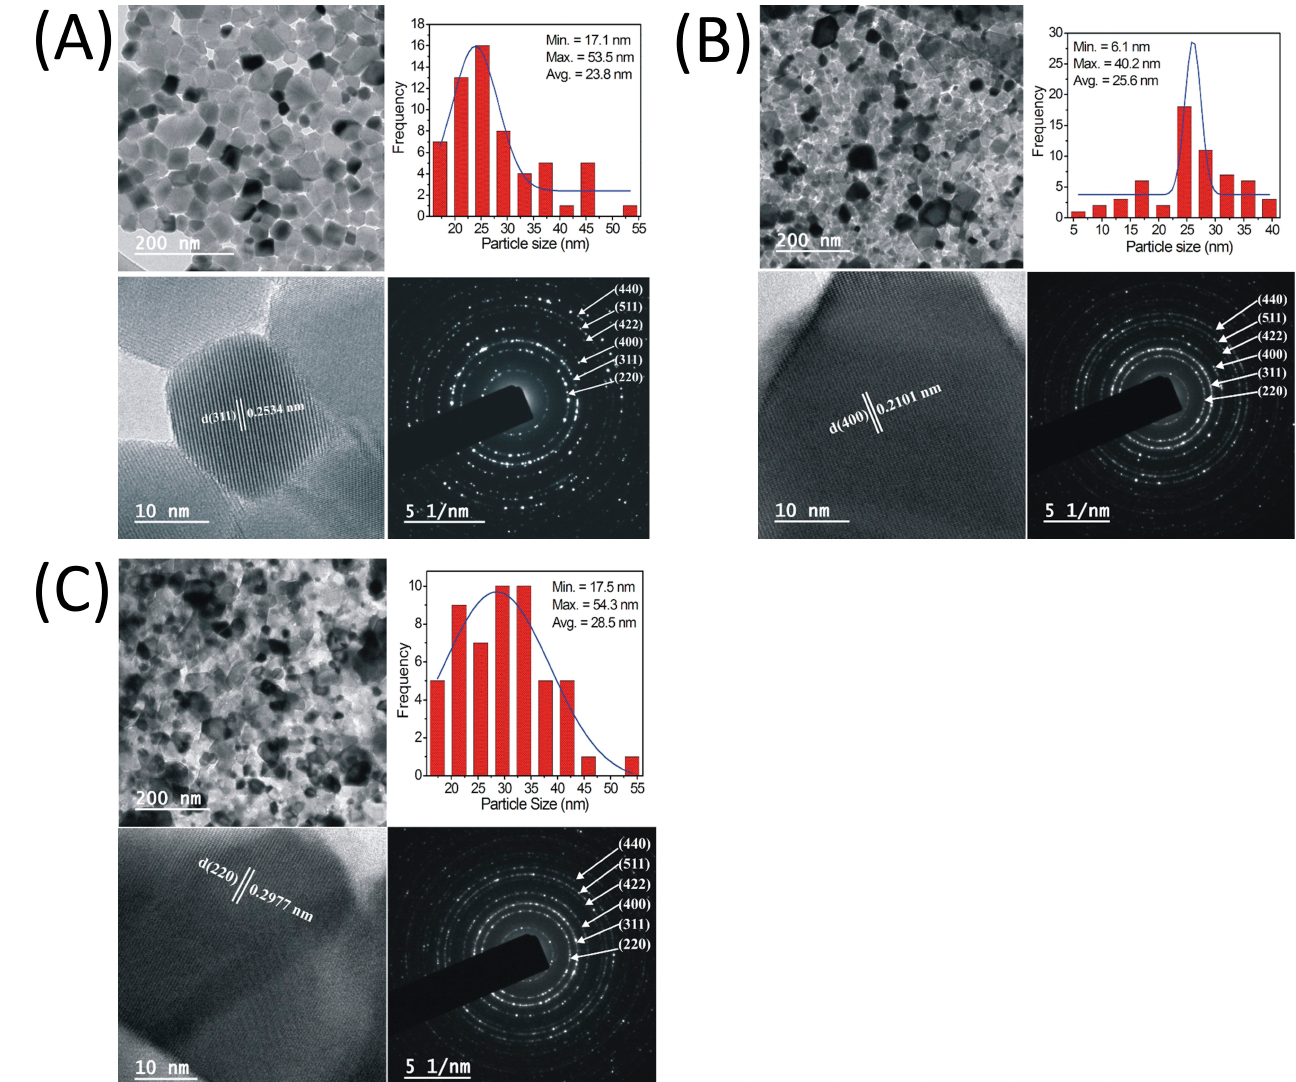
Figure 8. TEM, HRTEM, particle size distribution and SAED patterns of CoCr 0.5 Dy x Fe 1.5 − x O 4 for ( A ) x = 0.0, ( B ) x = 0.05 and ( C ) x = 0.1.